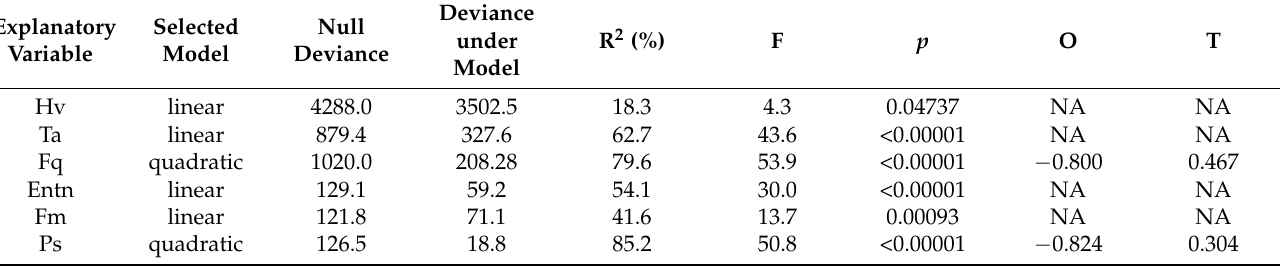
Figure 4. Fitted Collembola species response models, using a generalised linear model (GLM) with a second-order polynomial of the predictor variable (habitat scores). T: coastal tundra, OA: old algae (decaying macroalgae debris), FA: fresh algae (living macroalgae). The full names of the abbreviated species are given in Table 3. Table 6. GLM regression models for selected Collembola species responses to the seashore habitat gradient. Model based on F-test selection. R 2 : coefficient of determination, F: value of the F-ratio statistic, p : significance level of the model, O: parameter of species optimum, T: parameter of species tolerance. The full names of the abbreviated species are given in Table 3.